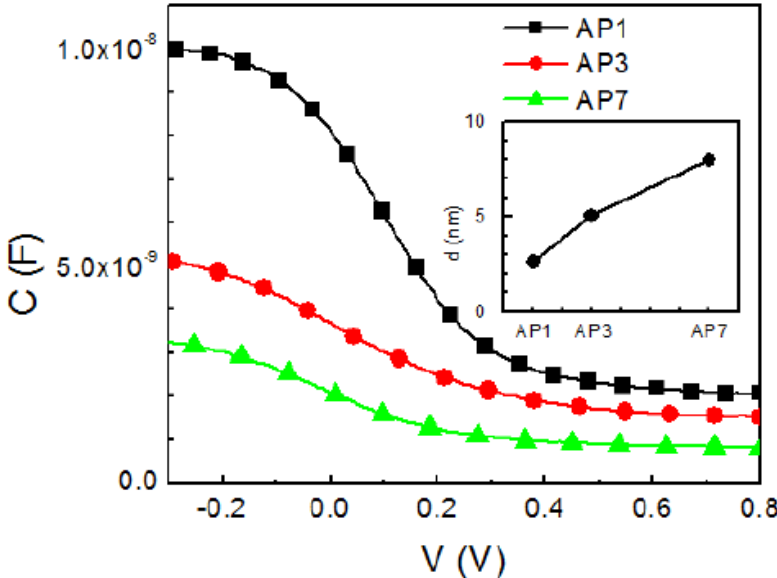
Figure 4. The capacitance − voltage (C − V) characteristics of Ga 2 O 3 MOS AP1, AP3, and AP7. The effect of oxide thickness d for each sample was shown in the inset.